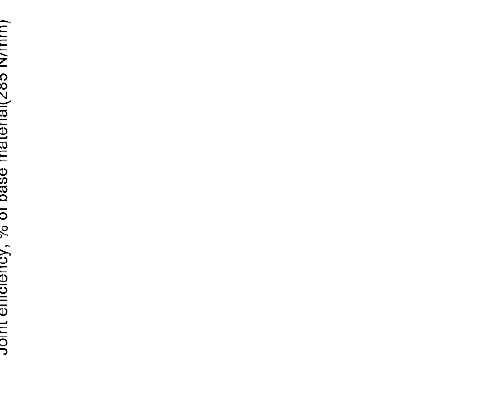
Figure 10. Maximum linear load during lap shear tensile test as function of welding parameters.